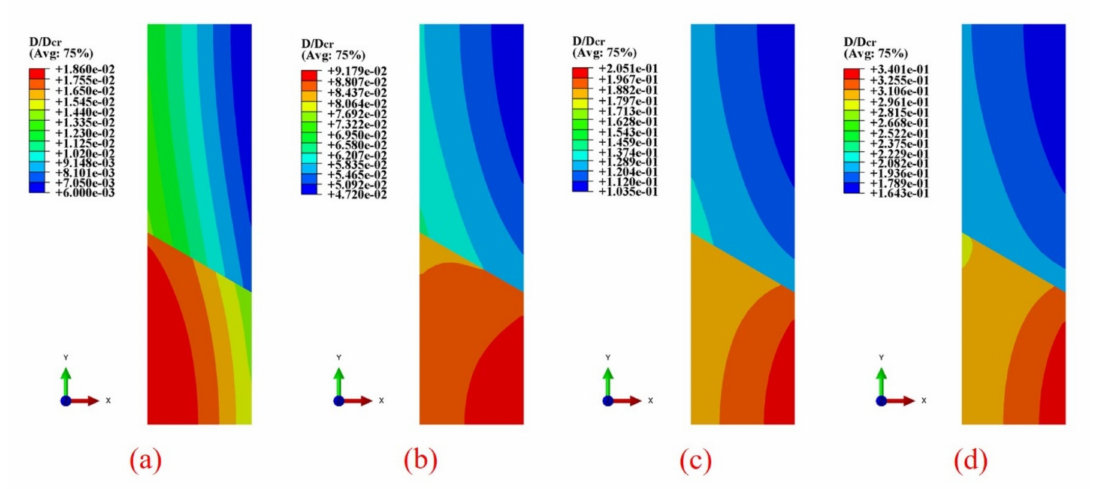
Figure 14. Damage distribution of the fresh-to-aged welded joint at ( a ) 1 × 10 4 , ( b ) 5 × 10 4 , ( c ) 1 × 10 5 , and ( d ) 1.5 × 10 5